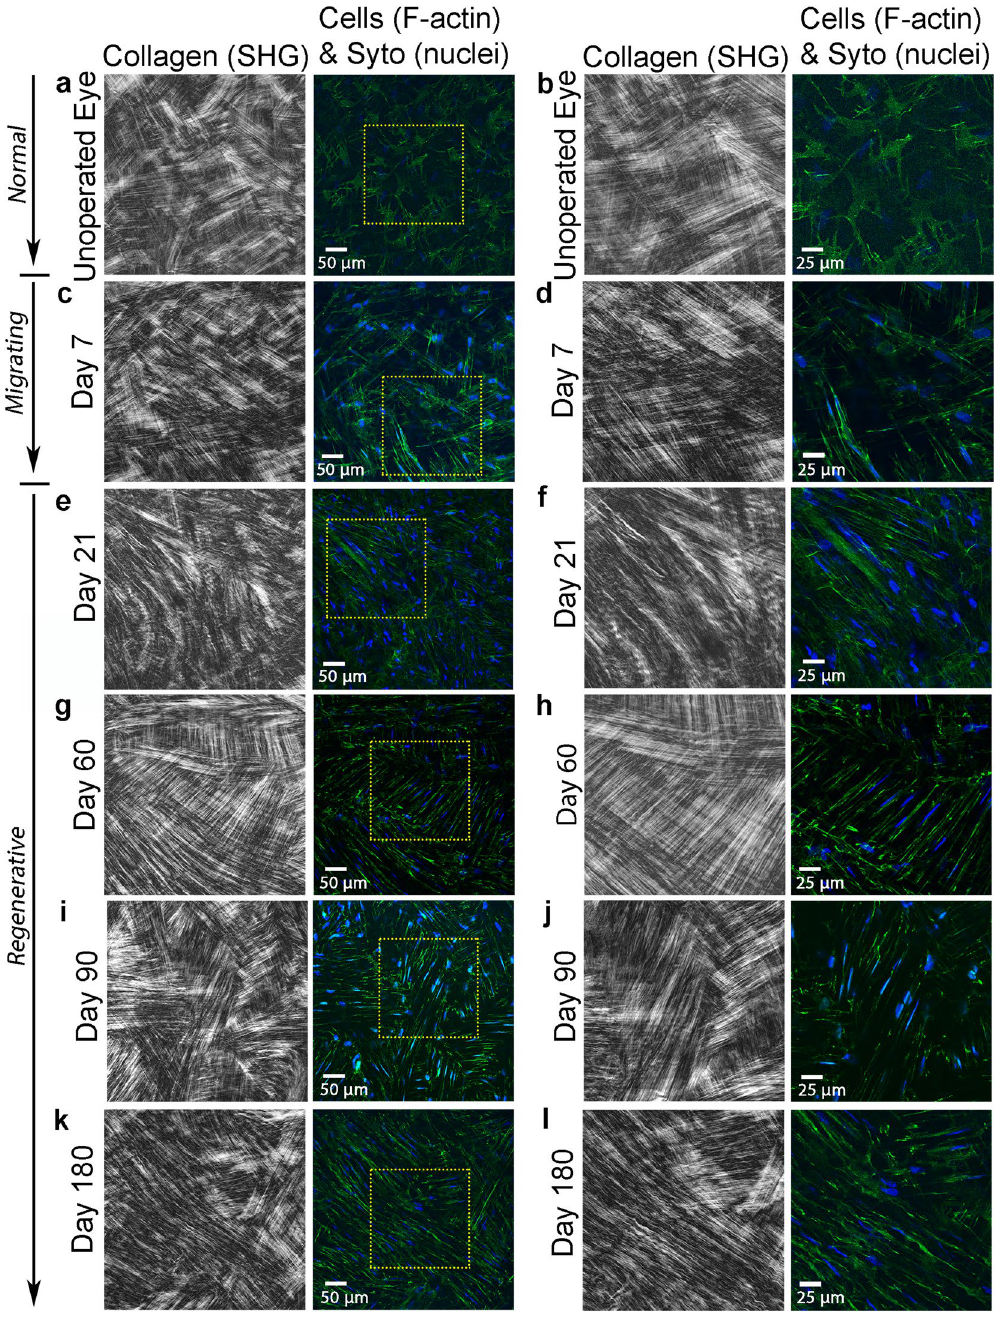
Figure 5. SHG forward scatter (collagen) and multiphoton fluorescent (F-actin-green, and nuclei-red) en face images. Images are from: ( a , b ) unoperated cornea, and ( c , d ) 7 days, ( e , f ) 21 days, ( g , h ) 60 days, ( i , j ) 90 days, and ( k , l ) 180 days after PRK. Images ( a , b ) were taken 128 µ m posterior to the basal lamina, and c, d were collected 40 µ m posterior to the photoablation site in the migrating region. Images e-l were collected from the regenerative region below the photoablated surface. Images ( b , d , f , h , j , l ) are 2x zoomed-in (yellow box) images from ( a , c , e , g , i , k ),